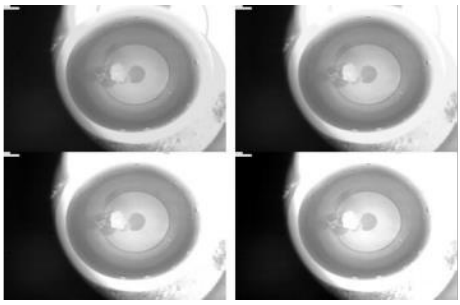
Figure 2. Image with adjusted grayscale values.